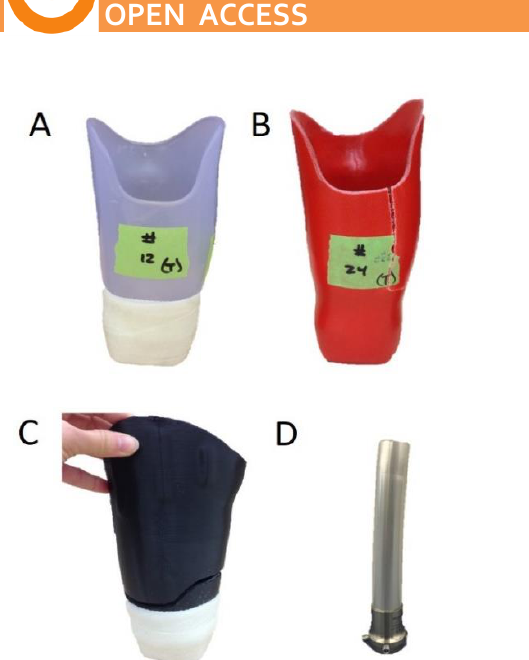
FIGURE 5. Typical failure methods for sockets made for cushion liners for the following conditions: (A) thermoplastic sockets at Condition I (B) laminated composite sockets at Condition I (C) 3D Printed PLA sockets at Condition I (D) sockets of all material types at Condition II.